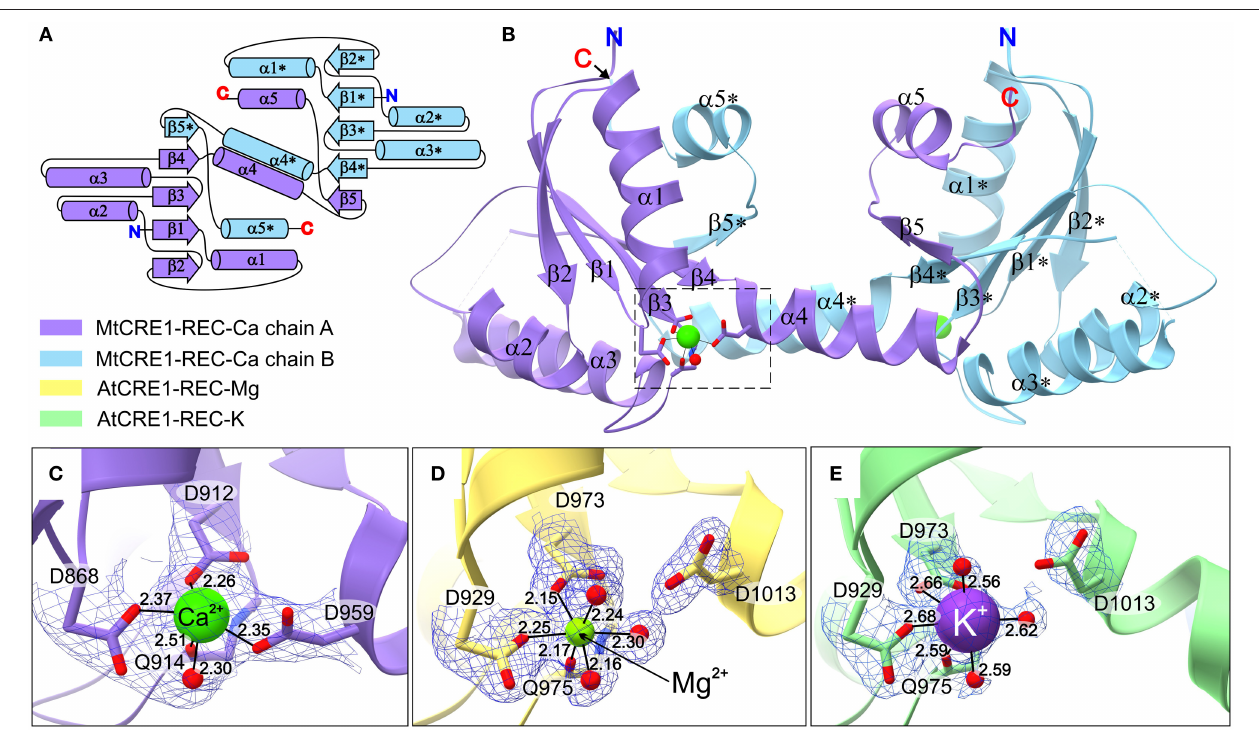
FIGURE 2 | The structure of CRE1-REC. (A) Shows the topology diagram, while (B) illustrates the quaternary structure (in cartoon representation) of MtCRE1-REC. The homodimer consists of two subunits, chain A (purple) and chain B (blue). Each chain has a flavodoxin-like core ( β 1 → β 4), in which a parallel β -sheet ( β 2 − β 1 − β 3 − β 4) is flanked by two layers of helices ( α 1 − α 5* and α 2 − α 3; an asterisk denotes an element of the other subunit) and a 3D swapping subdomain ( α 4 − β 5 − α 5). In this structure, each subunit binds a Ca 2 + cation (C) . AtCRE1-REC has a similar structure with two species of the metal cation, Mg 2 + (yellow) or K + (green), shown in (D,E) , respectively. The metal coordination is shown in 2mFo-DFc electron density contoured at the 1 σ level, and the coordination bonds are marked as thin black lines, with bond distances in